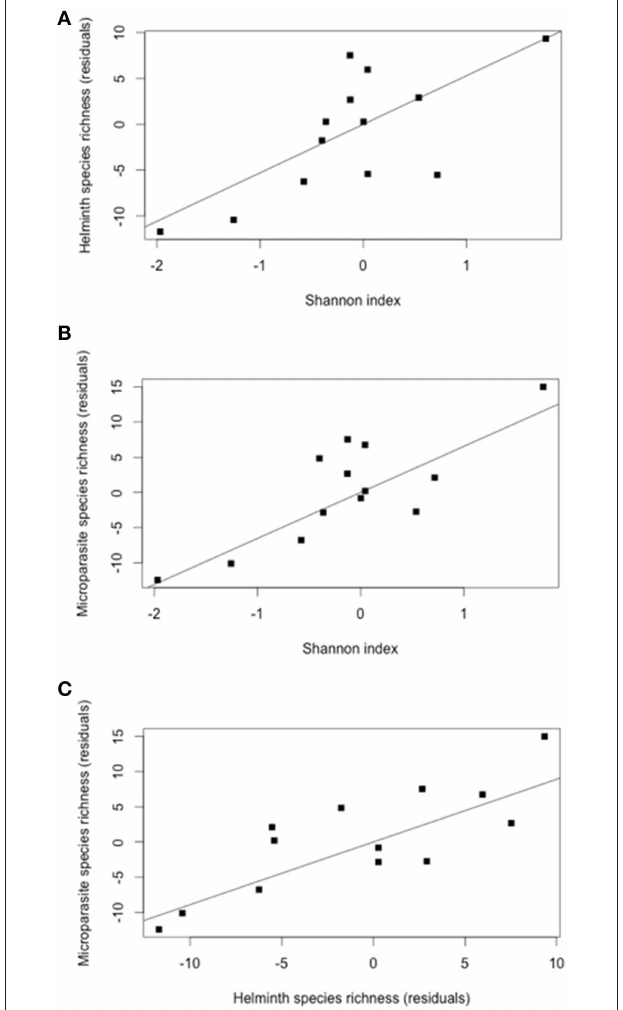
FIGURE 2 | (A) Partial regression between the residuals of contrasts in helminth species richness and the residuals in Shannon index (controlling for the contrasts in host abundance, using the model of Table 2 ); ( R 2 = 0.52 , P = 0 .004). (B) Partial regression between the residuals of contrasts in microparasite species richness and the residuals in Shannon index (controlling for the contrasts in host abundance, using the model of Table 2 ) ( R 2 = 0.63 , P = 0 .0007). (C) Partial regression between the residuals of contrasts in microparasite species richness and the residuals in in helminth species richness (controlling for the contrasts in host abundance and in Shannon index, using the model of Table 2 ); ( R 2 = 0.63 , P = 0 .0007).